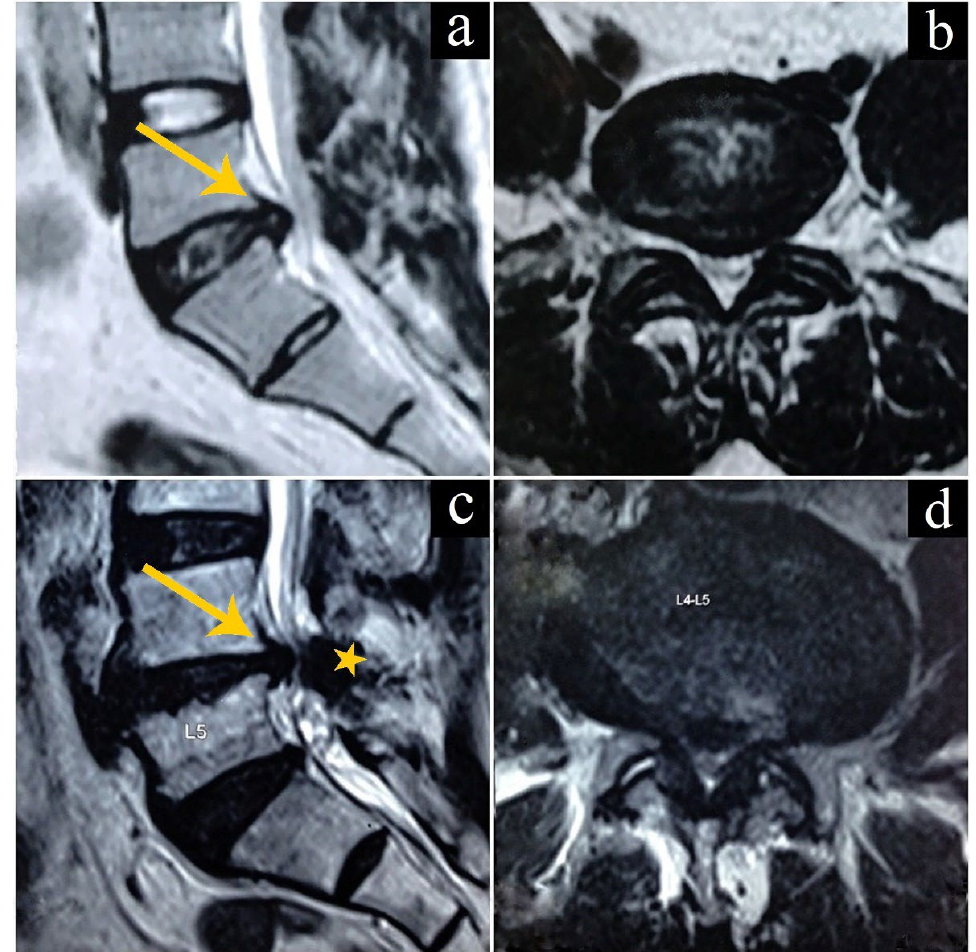
Figure 1. MRI images showing intervertebral disc herniations. ( a ) Sagittal view showing L5-S1 disc herniation (arrow), ( b ) corresponding axial view, ( c ) Sagittal view showing front and back compression due to herniating L4-L5 disc (arrow) and a thick buckled ligamentum flavum (star), ( d ) corresponding axial view showing circumferential compression.